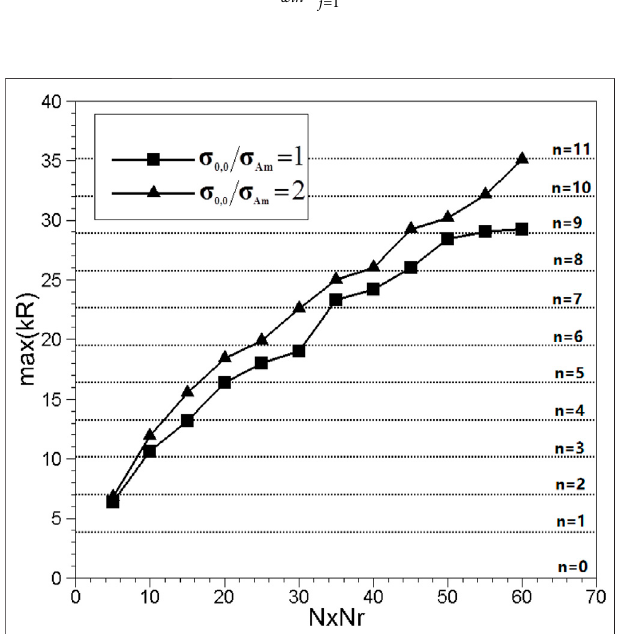
FIGURE 9 | Required sensors under a given threshold value of relative standard